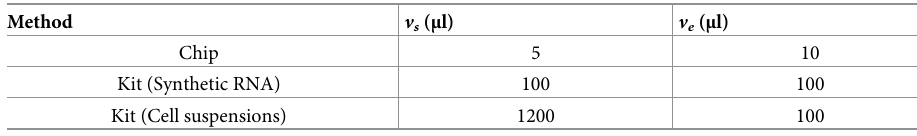
Table 3. Sample and elution volumes used for the chip and kit extractions. Method Kit (Synthetic